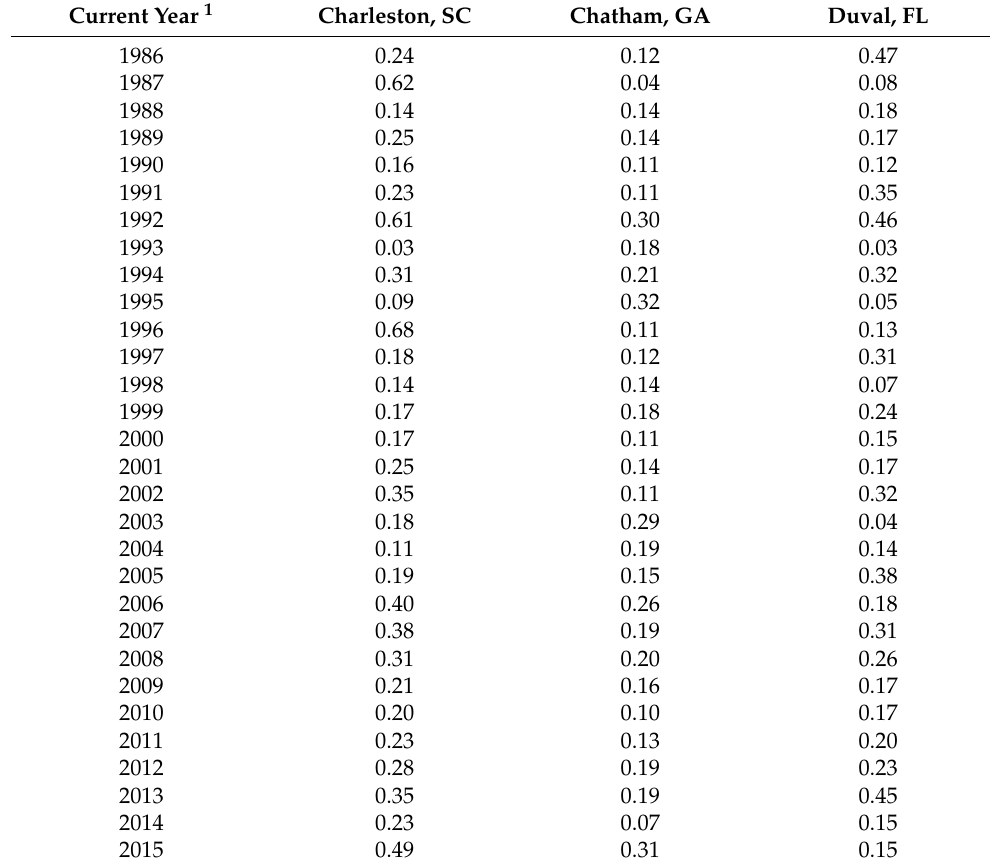
Table 1. The annual distribution of newly urbanized tidal flats in the three counties (in km 2